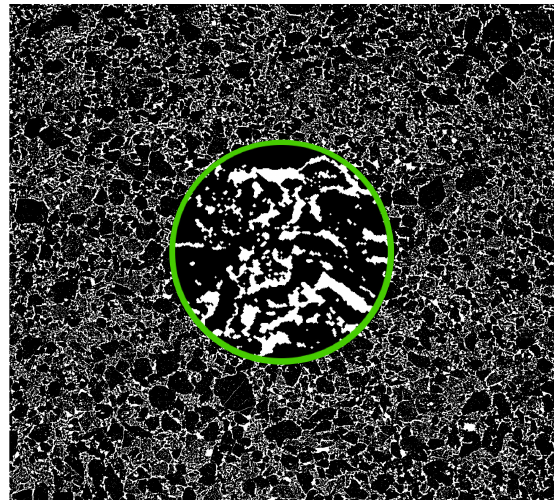
Figure 5. Result of improper segmentation in grey in- tensity space leading to substantial loss of information with upscaled detail of over-segmented